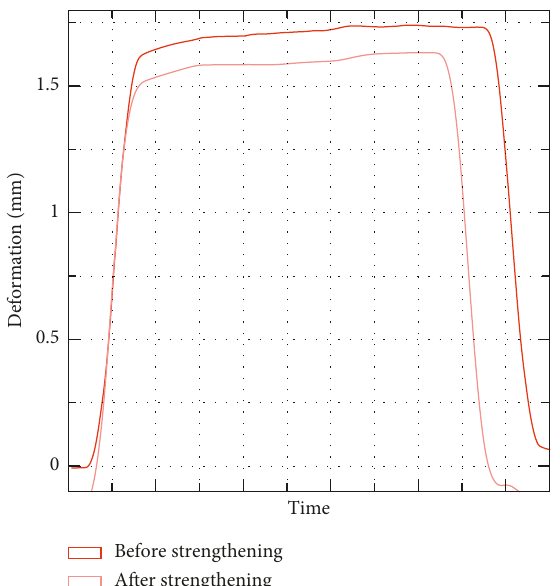
Figure 26: A comparison of the measured deflections of the cross girder before and after the strengthening with the same test vehicles in the same position on the U-shaped bridge built in Vraˇzn´e in 1928